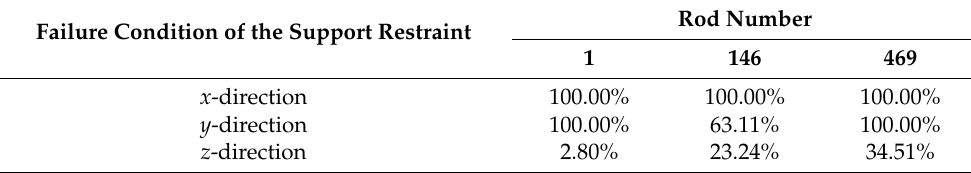
Table 2. Damage probability of each member under different bearing failure